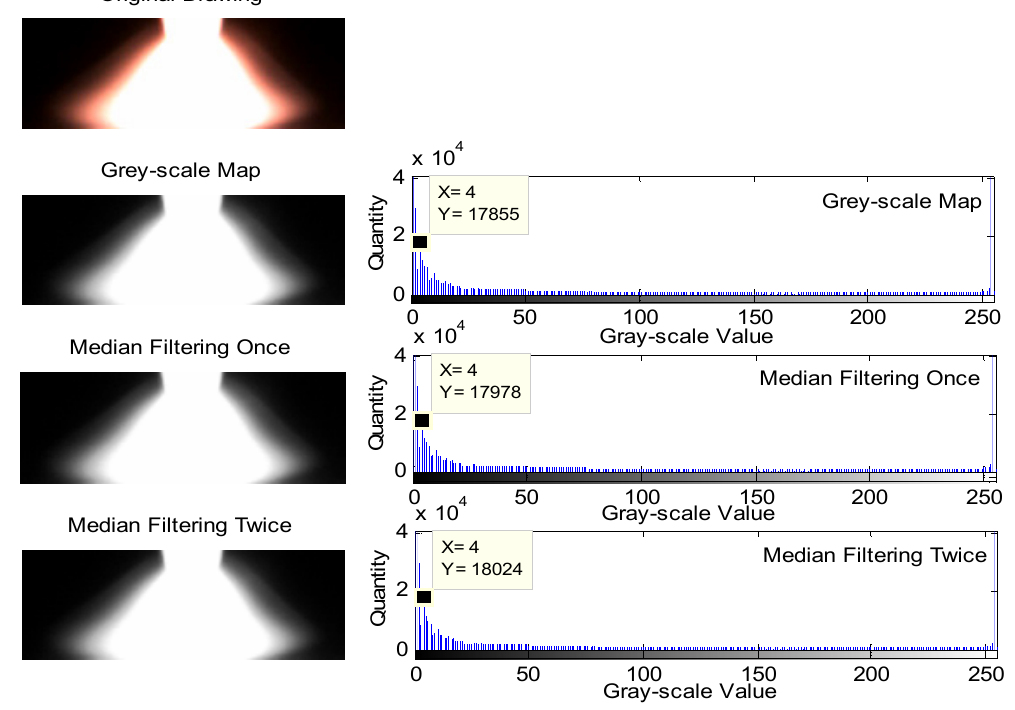
Figure 2. De ‐ noising processing (80 A, 20 kHz). Figure 2. De-noising processing (80 A, 20